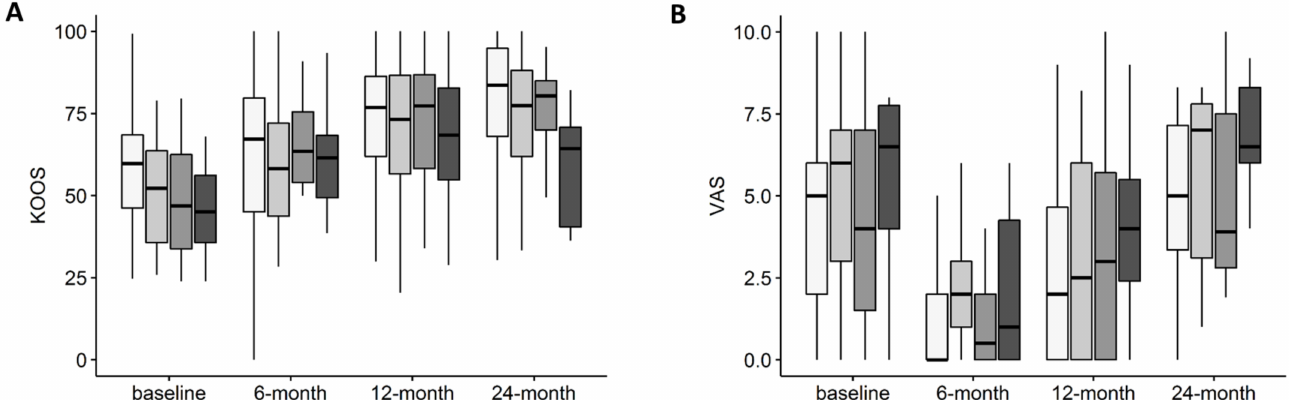
Figure 3. ( A ) Total KOOS score over time in patients with different OA KL grade treated with intra-articular injection of MFAT. ( B ) VAS score over time in patients with different OA KL grade treated with intra-articular injection of MFAT. KL1 n = 80, KL2 n = 46, KL3 n = 32, KL4 n =